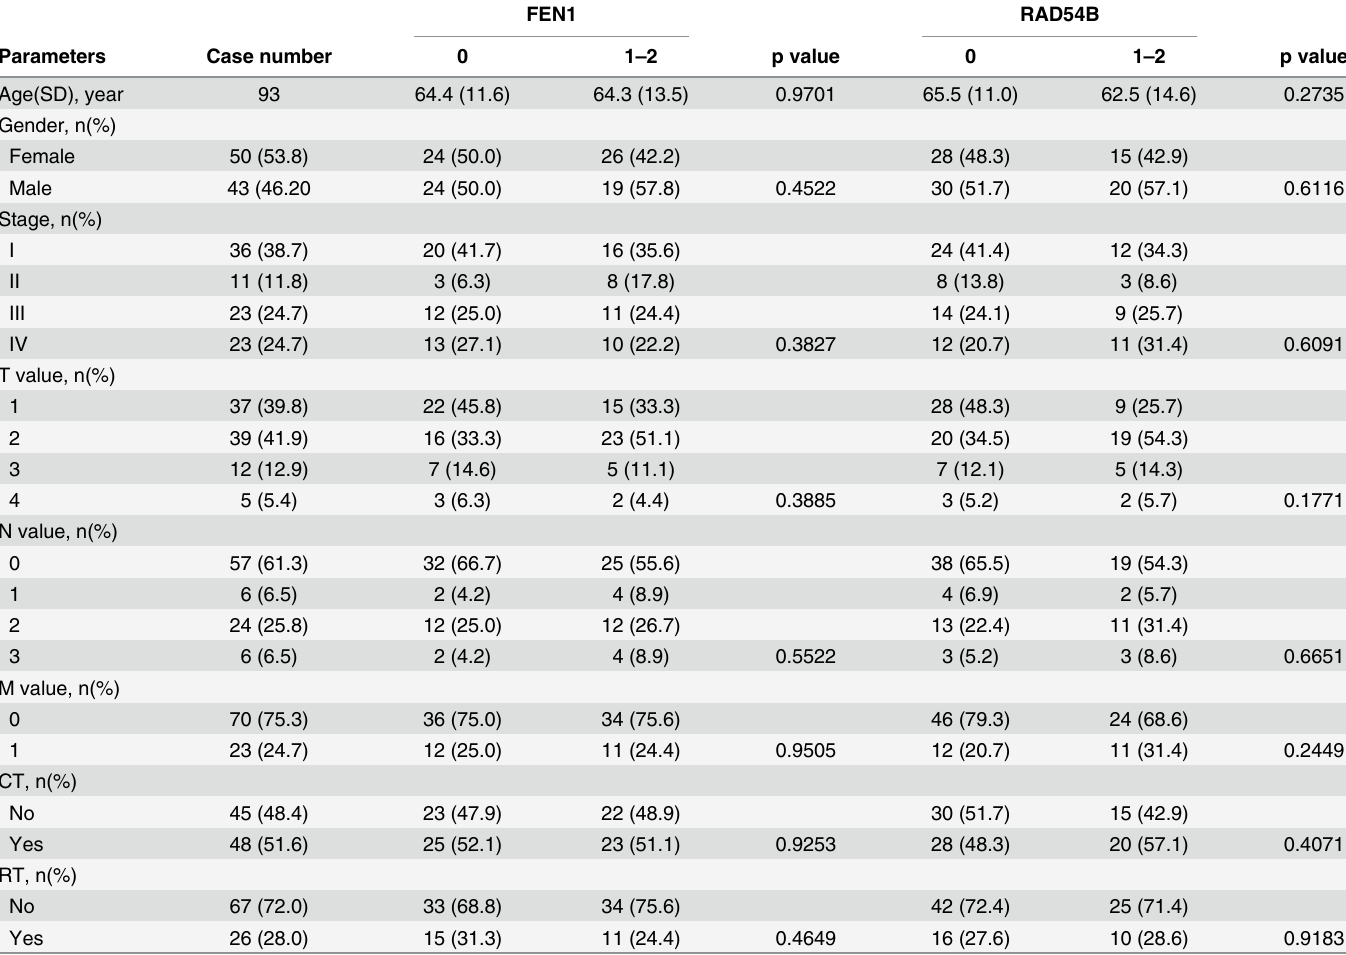
Table 2. Relationships of FEN1 and RAD54B expression with clinical parameters in lung adenocarcinoma